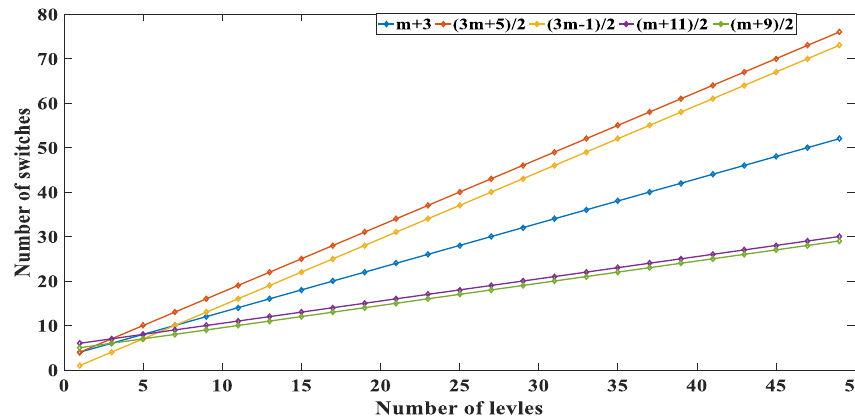
Fig. 3 Graph of number of switches vs. number of levels for circuits of [25–30]